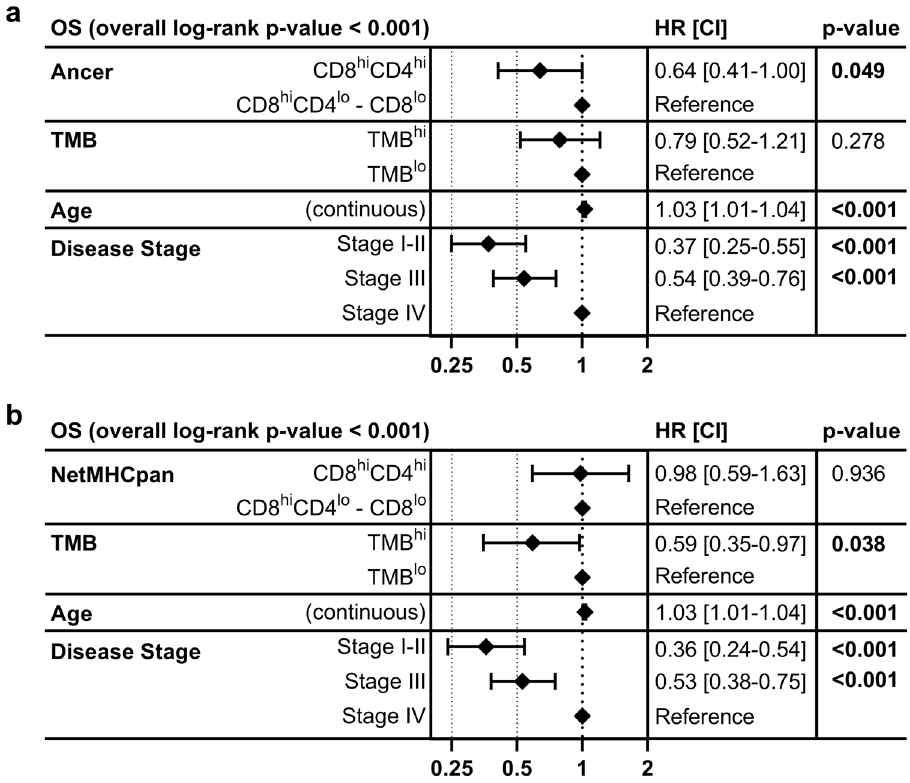
Figure 7. Multivariate survival analysis forest plots. Ancer neoepitope burden remains a significant co-factor associated with overall survival when adjusting for TMB, age, and disease stage ( a ). NetMHCpan